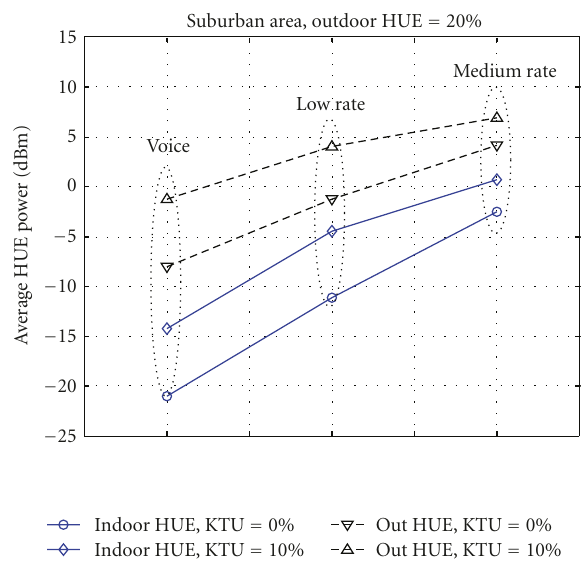
Figure 6: Average transmit power of HUEs in suburban